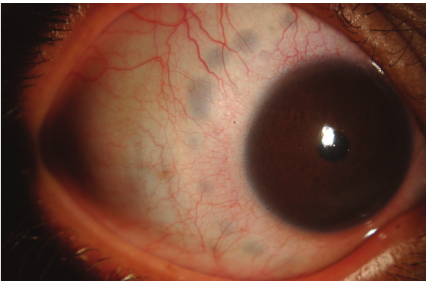
Figure 5: Scleral thinning spots after transcleral diode laser cyclo- photocoagulation in pediatric